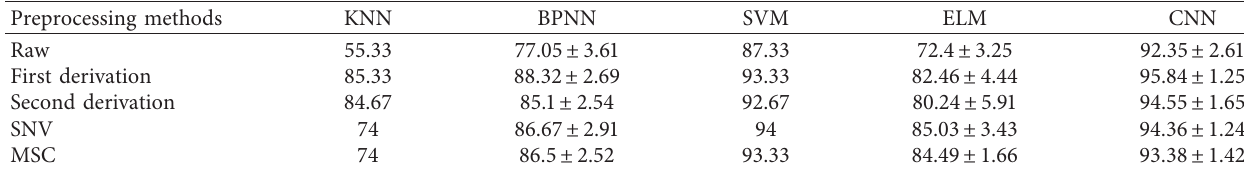
Table 3: Discriminant accuracy (%) of different preprocessing methods.